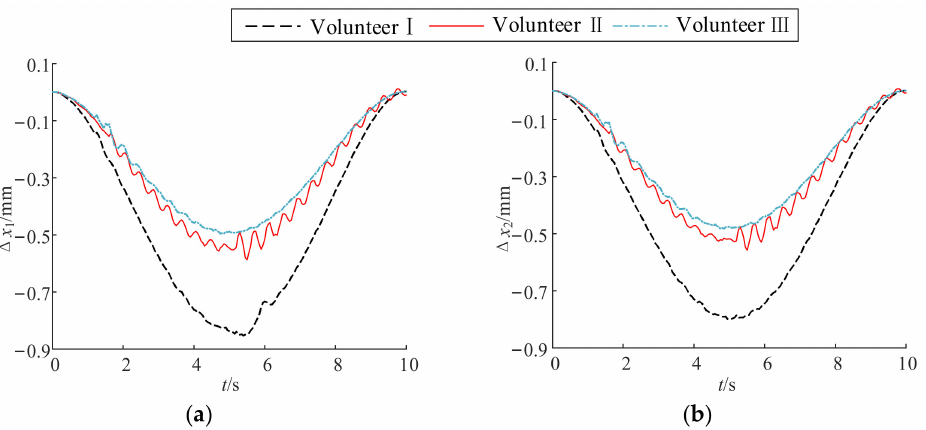
Figure 16. Track tracking error of sliders. ( a ) Track tracking error of slider C 1 . ( b ) Track tracking error of slider C 2 .